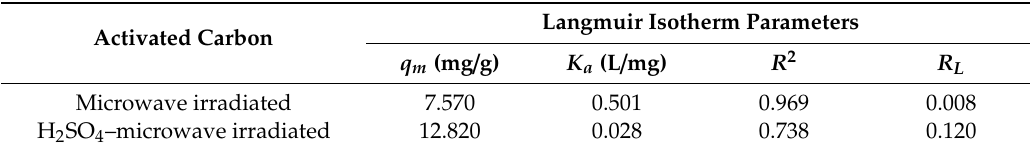
Figure 8. Pictorial view of color removal at 5 h contact time: ( a ) microwave irradiated and ( b ) H 2 SO 4 – microwave irradiated at varied adsorbent dosages in 200 mL (A = control, B = 3 g, C = 6 g, D = 9 g, E = 12 g, F = 15 g). Table 6. Langmuir adsorption isotherm Table 6. Langmuir adsorption isotherm analysis.